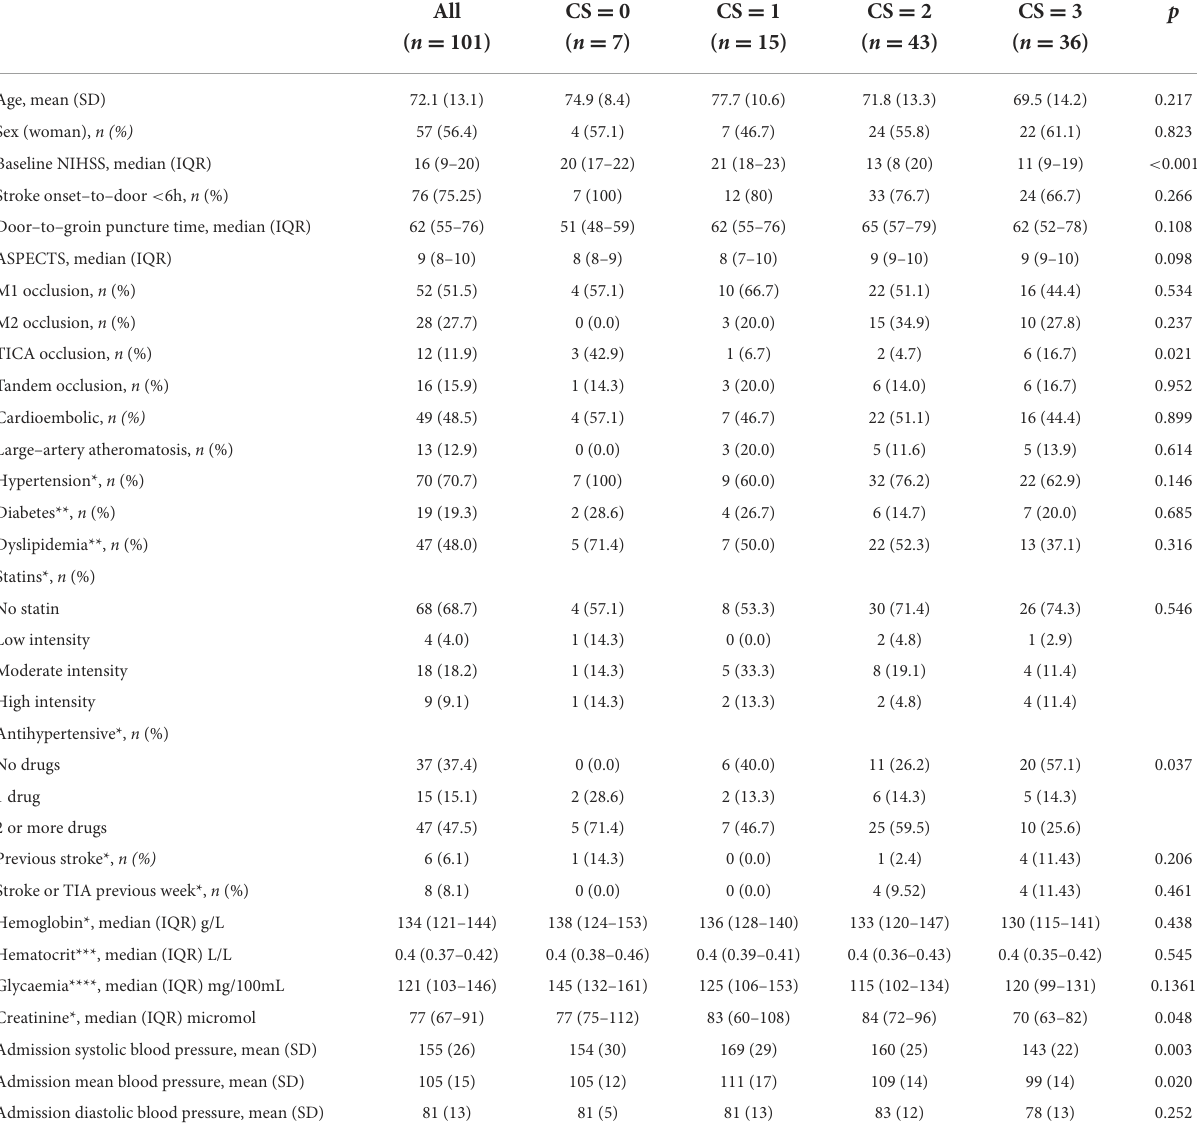
TABLE 1 Bivariate analyses of predictors of collaterals classified by CS